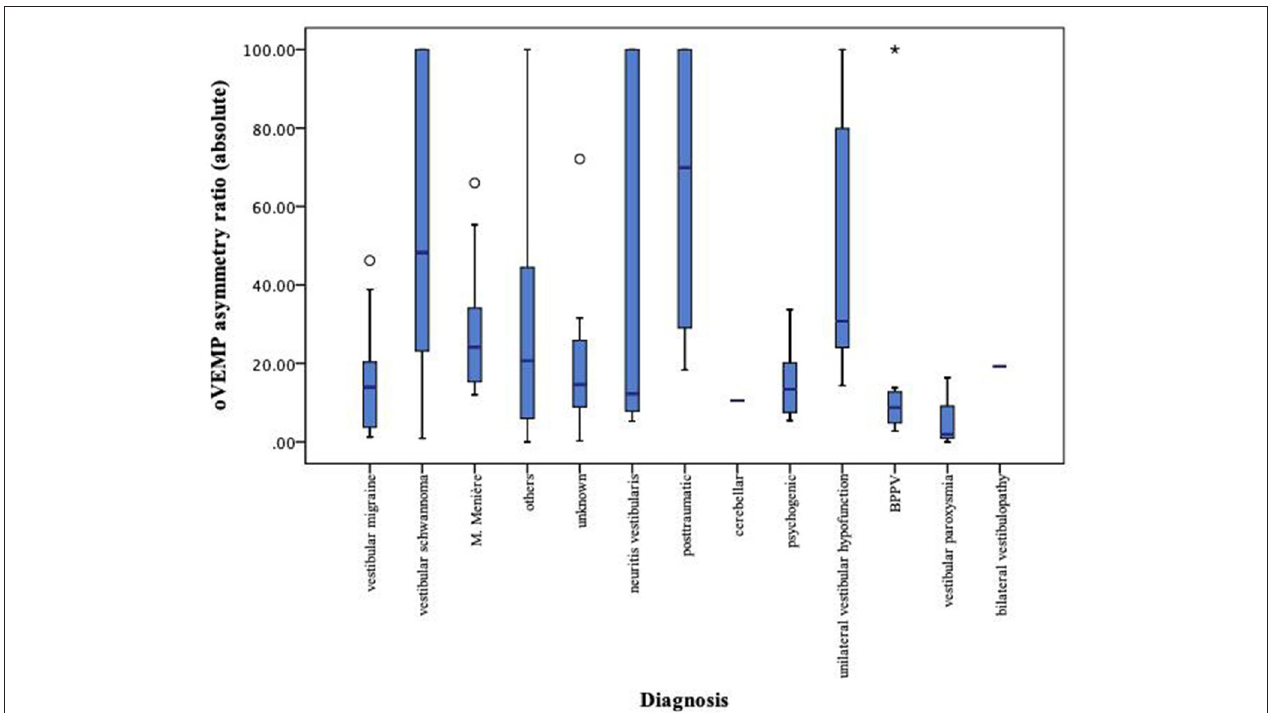
FIGURE 7 | Boxplot of oVEMP measurements for each diagnosis separately. oVEMP, ocular vestibular evoked myogenic potential; left-sided values (original data = < 0) and right-sided values (original data = > 0) both expressed as positive values. *Extreme value, below quartile 1 or above quartile 3.